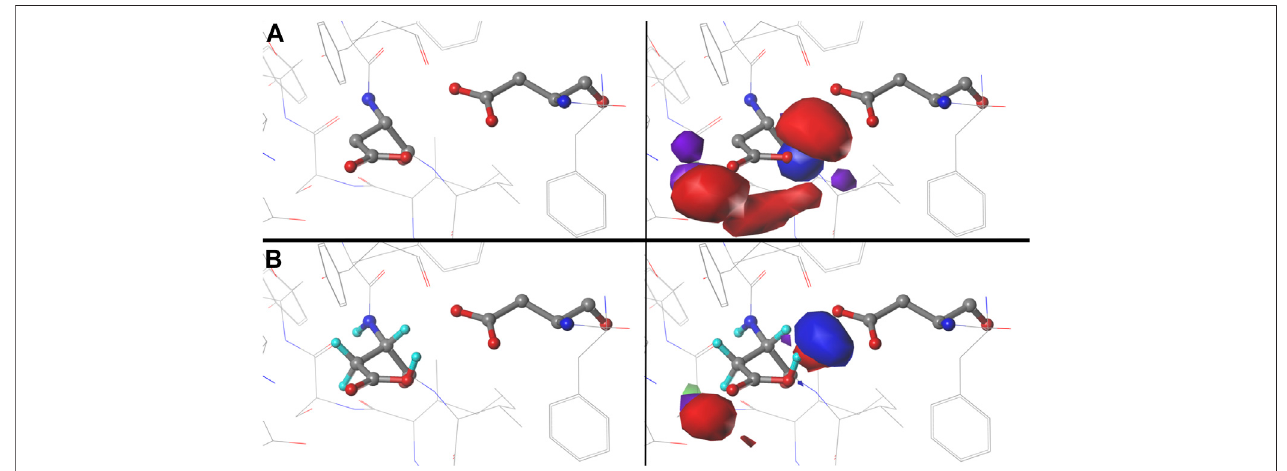
FIGURE 12 | Variations in mapped environments around ASP141A in PDB structure 1WNS. (A) structure model mapped environment around deprotonated ASP141A with strong unfavorable polar interaction between it and nearby residue ASP215A (pH 9). (B) structure model and mapped environment around protonated ASP141A with new strong, favorable polar interaction with ASP215A (pH 5).